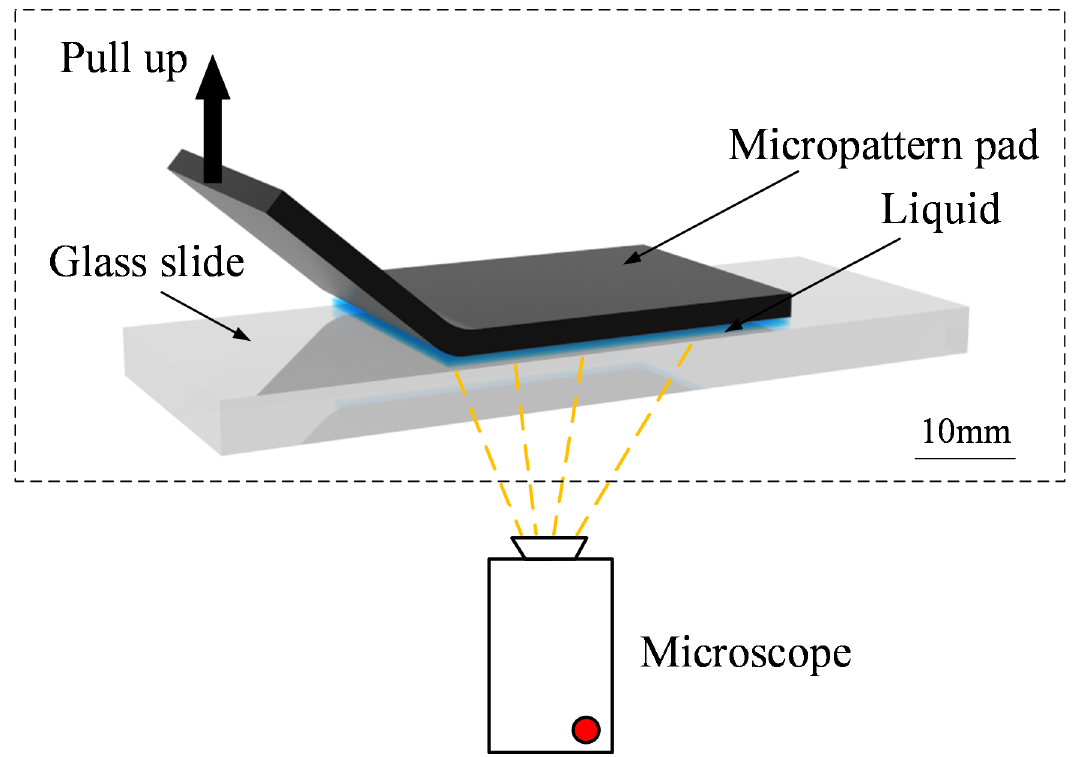
Figure 5. Configuration of the dynamic observation setup.